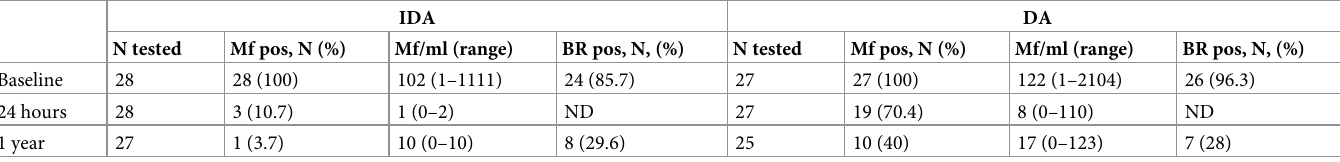
Table 2. Parasitological and serological parameters pre-treatment and at 24 hours and one year after treatment. IDA DA N